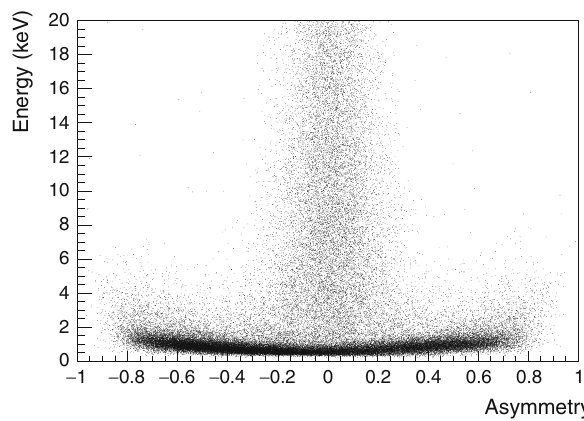
Fig. 19 Energy versus asymmetry for Crystal-1 (see text for the def- inition of asymmetry). Further noise event reduction is accomplished by a selection criteria based on the asymmetry of the total charges mea- sured by the two PMTs. The middle vertical band centered near zero is predominantly due to β -/ γ -ray-induced events inside the crystal, while the highly asymmetric events with energies below a few keV are due to events that are likely of PMT origin